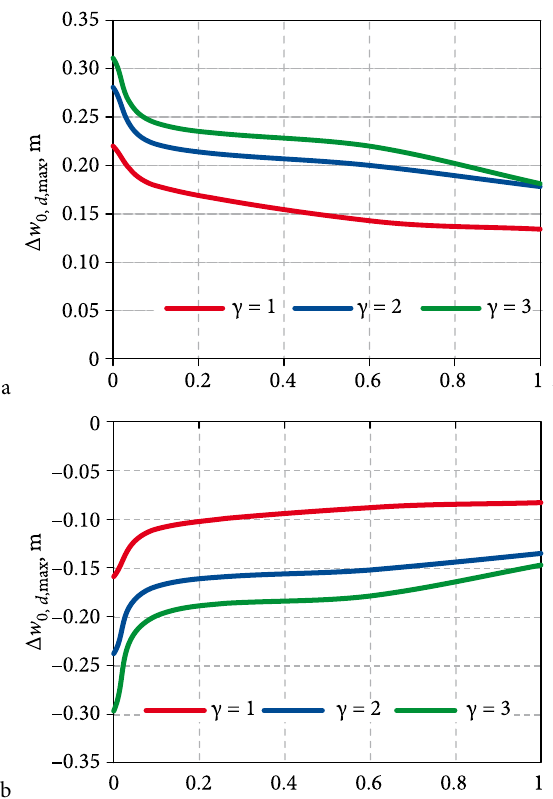
Fig. 7 . Vertical deflection in the left (a) and right (b) quarter points